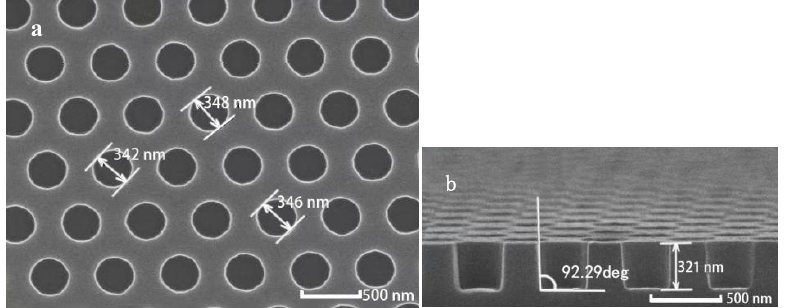
Figure 5. ( a ) Overhead and ( b ) cross-sectional SEM micrographs of the 2D grating. The grating array pattern was fabricated in the SiO 2 thin film layer, comprising a hexagonal arrangement of cylindrical holes.